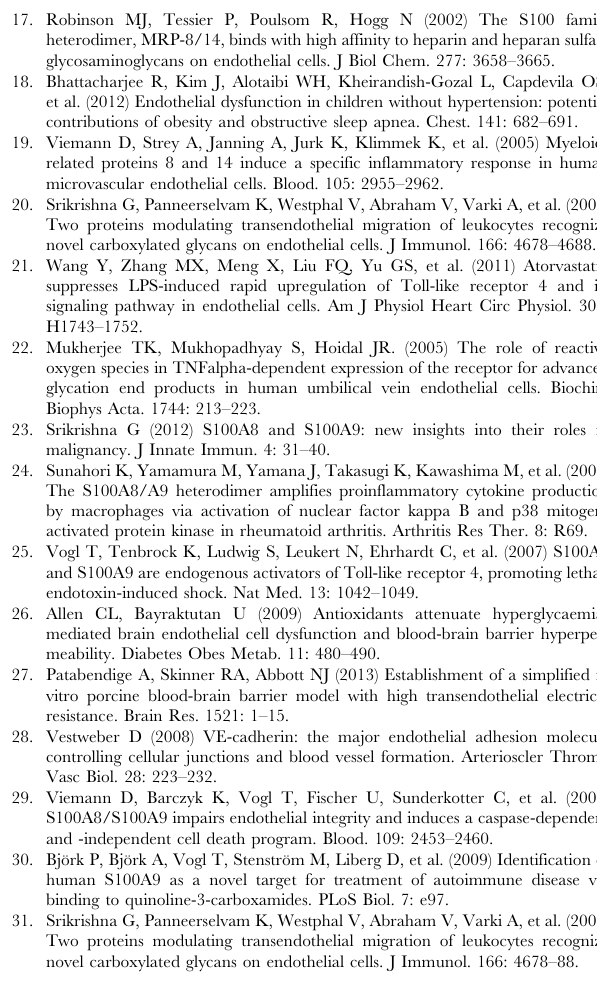
Figure S4 The effects of blocking TLR4 and RAGE on S100A8, S100A9 and S100A8/A9 stimulation of HUVECs. HUVECs were stimulated with S100A8 (2.0 m g/mL) ( A ), S100A9 (2.0 m g/mL) ( B ) and S100A8/A9 (2.0 m g/mL) ( C ) for 120 min with or without 60 min pre-incubation with specific blockers (TAK242 for TLR4 and anti-human RAGE antibody for RAGE). Then the TER was measured. * P , 0.05 vs. Control, & P , 0.05 vs. (TIF) Figure S5 The effects of EGTA-induced depletion of extracellular calcium on endothelial permeability were also revealed, showing similar results with deprivation of calcium.